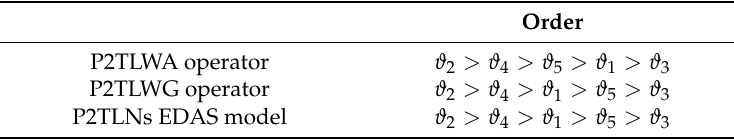
Table 11. Rank of alternatives by some P2TLN aggregation